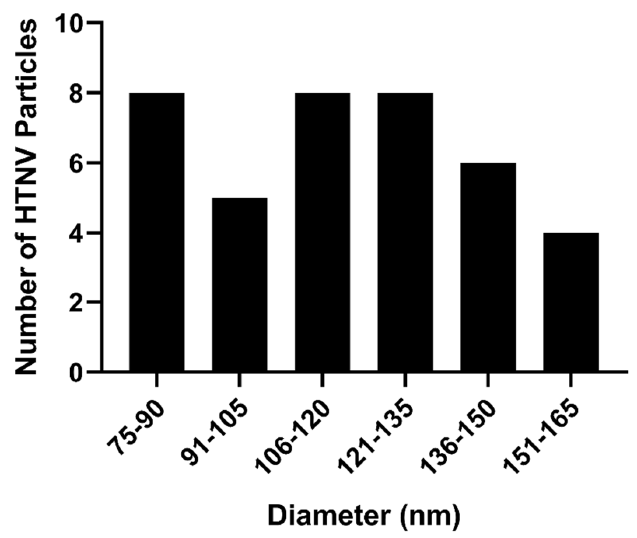
Figure 2. Histogram of diameters measured for HTNV virions with round morphology. The diameters of 37 virions with a round morphology were measured from several cryo-EM images.